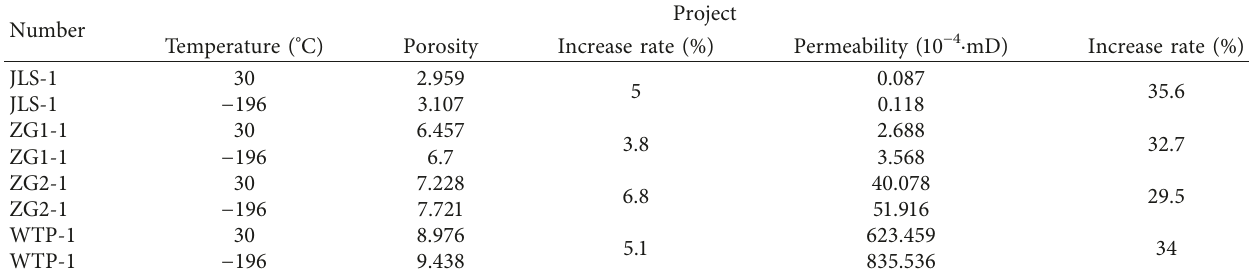
Table 2: Porosity and permeability of coal samples under low